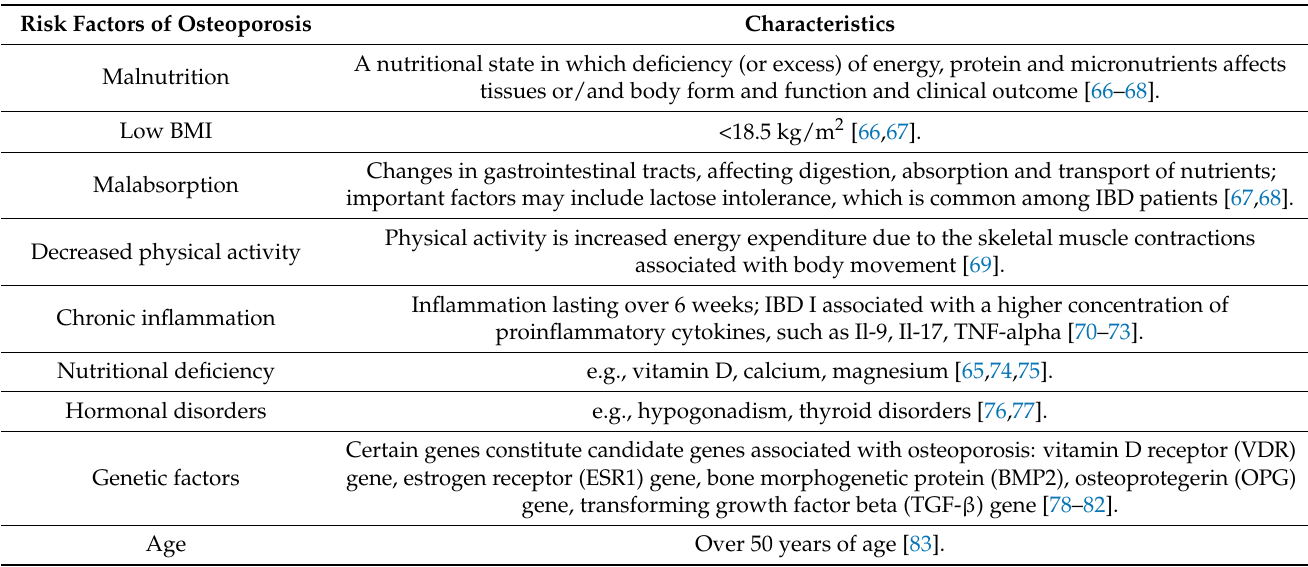
Table 3. The risk factors of osteoporosis inIBD patients